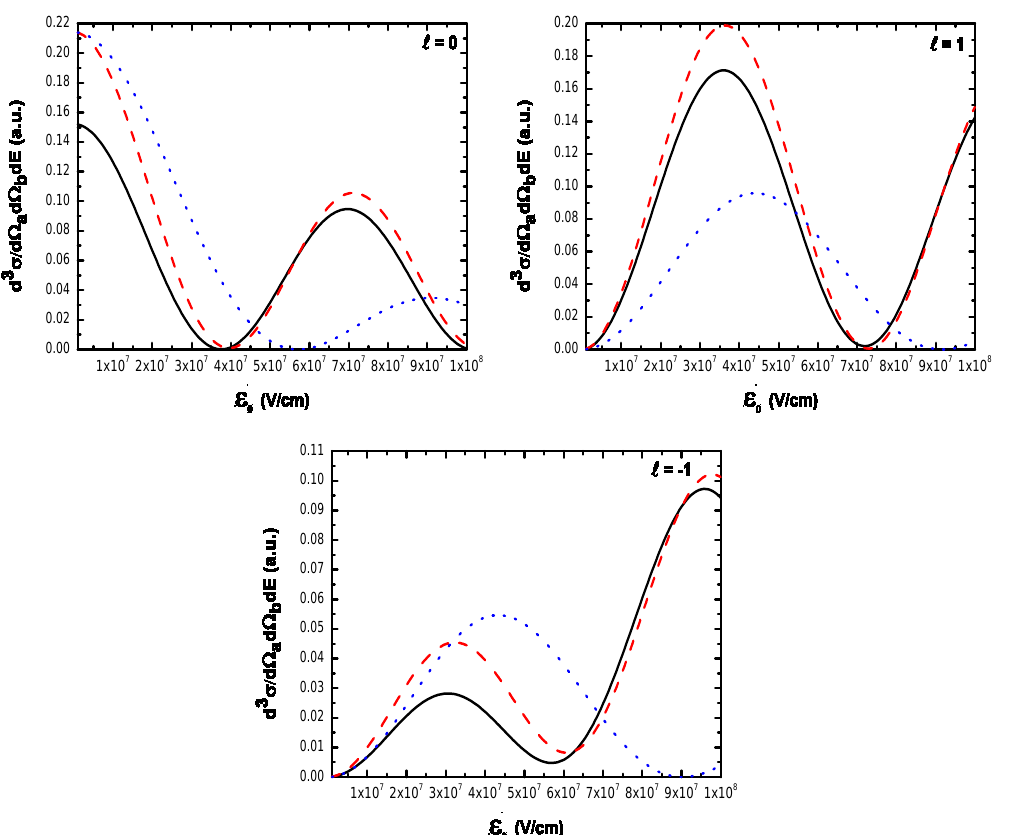
Figure 13. All the parameters are the same as Figure 12, while the laser polarization is perpendicular to the incident momentum ( ˆ ε ⊥ k i )